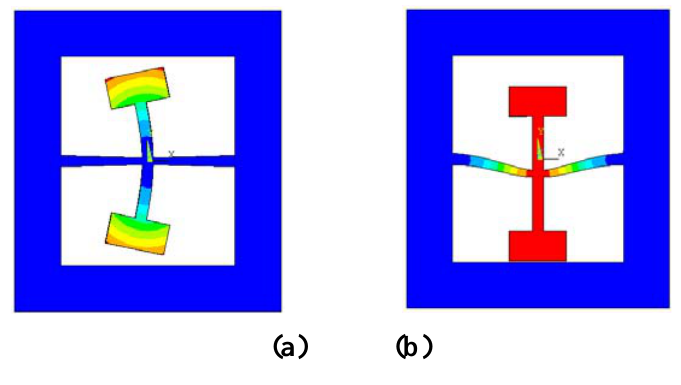
Figure 8. Mode analysis by ANSYS™. (a) Drive mode. (b) Sense mode.